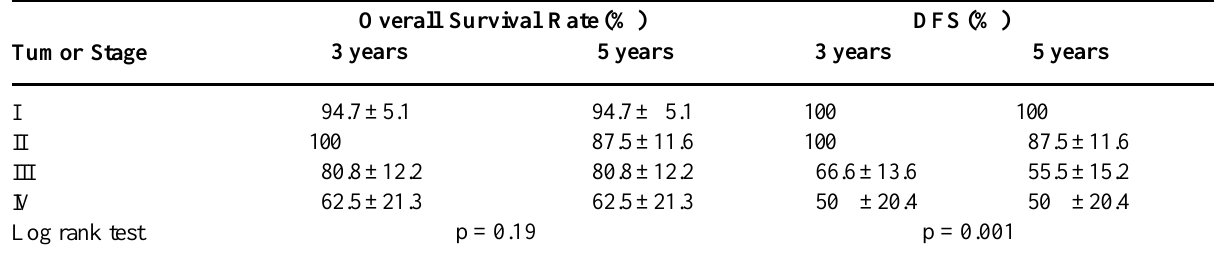
Table 3 – Overall and disease-free survival rates (DFS) according to tumor stage and time of follow-up. Tumor